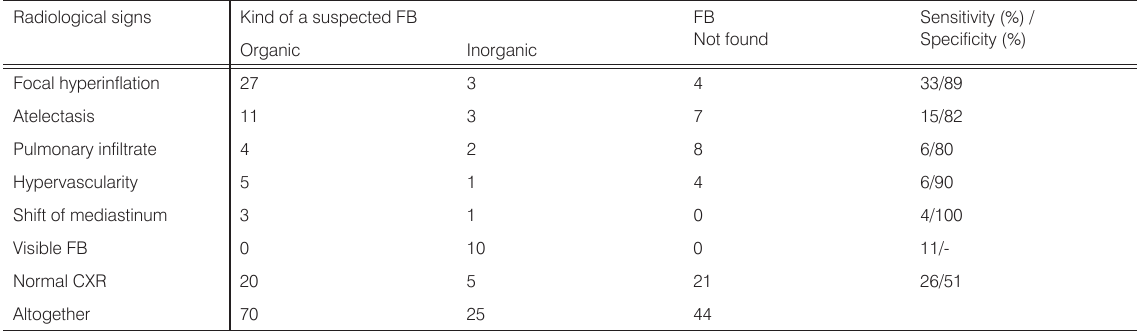
Table 2. Relationship between type of FB and radiological